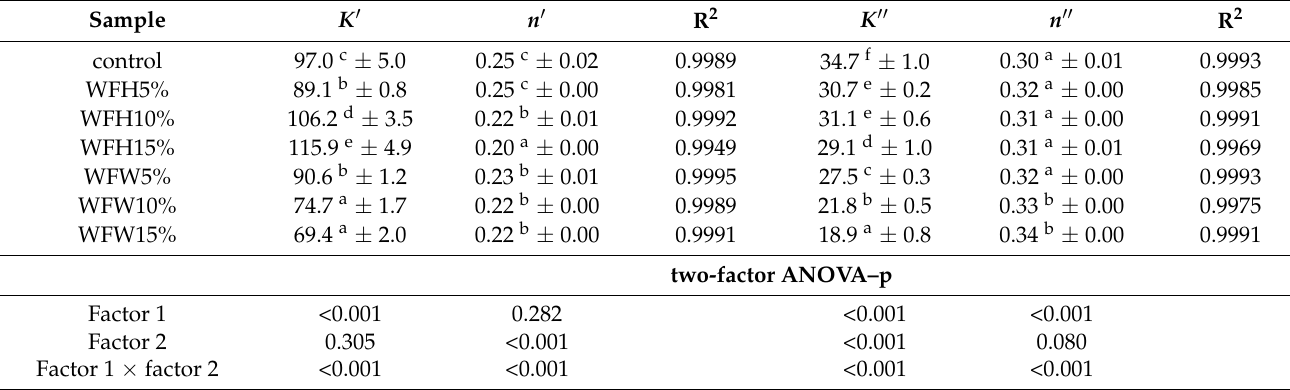
Figure 6. Tangent δ depending on the angular frequency of wheat flour gel and samples with walnuts addition. Table 3. Parameters of power law equations describing viscoelastic properties (25 ◦ C) of systems wheat flour with